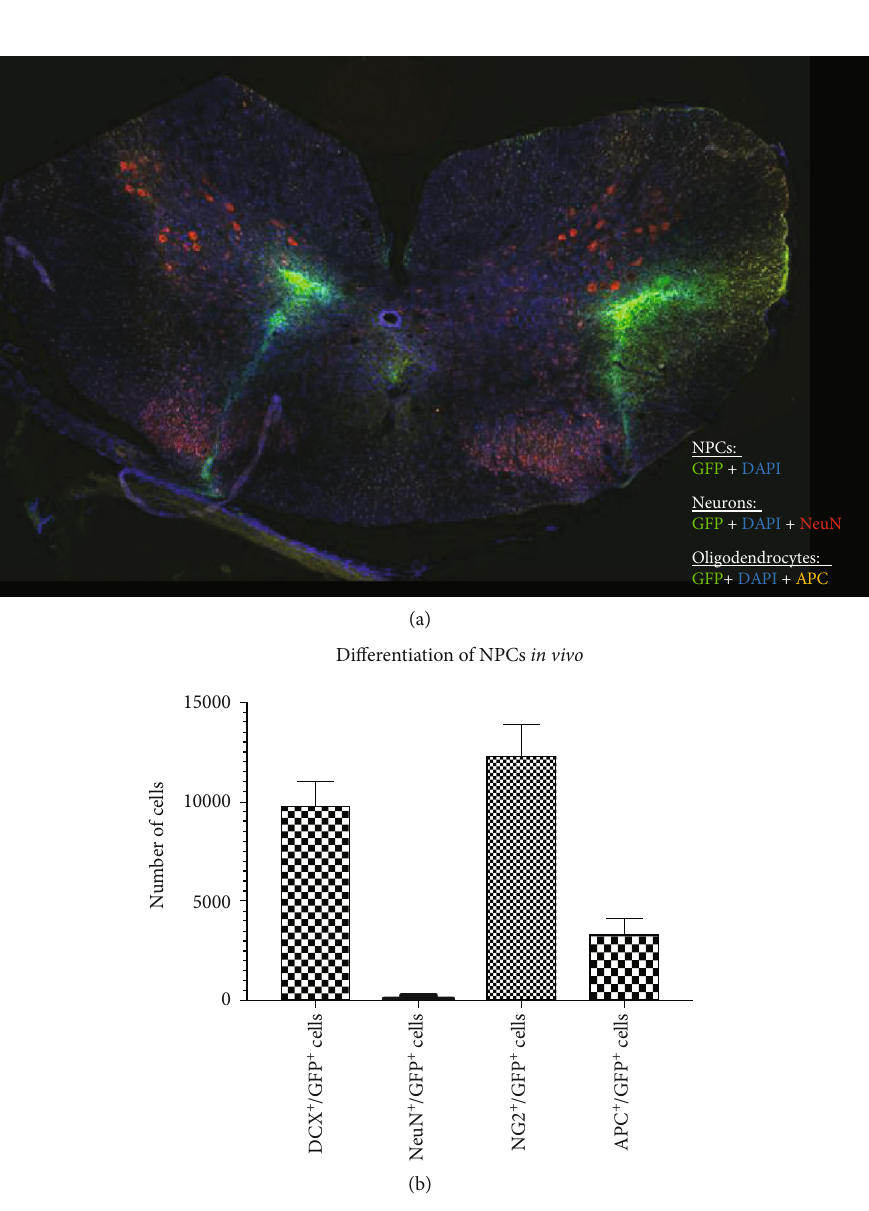
Figure 5: Di ff erentiation of transplanted NPCs in vivo 8 weeks after cervical SCI. (a) Spinal cord cross-section showing the spatial distribution of surviving NPCs (GFP + /DAPI + ), NPC-derived neurons (GFP + /DAPI + /NeuN + ) and NPC-derived oligodendrocytes (GFP + /DAPI + /APC + ). (b) Number of NPC-derived neuronal precursors (DCX + /GFP + ) and mature neurons (NeuN + /GFP + ) as well as oligodendrocyte precursors (NG2 + /GFP + ) and mature oligodendrocytes (APC + /GFP + ) in the injured spinal cord of animals in the NPC group (group